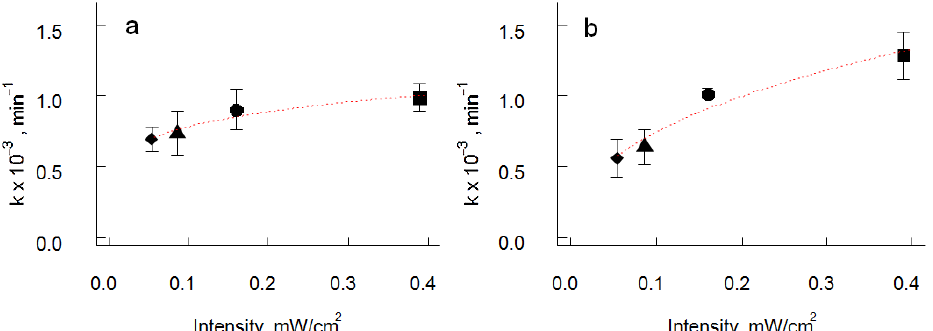
Figure 7. Methylene blue photo-degradation rate as a function of UV intensity for ( a ) a randomly oriented (<101>) TiO The dashed line is a guide to the